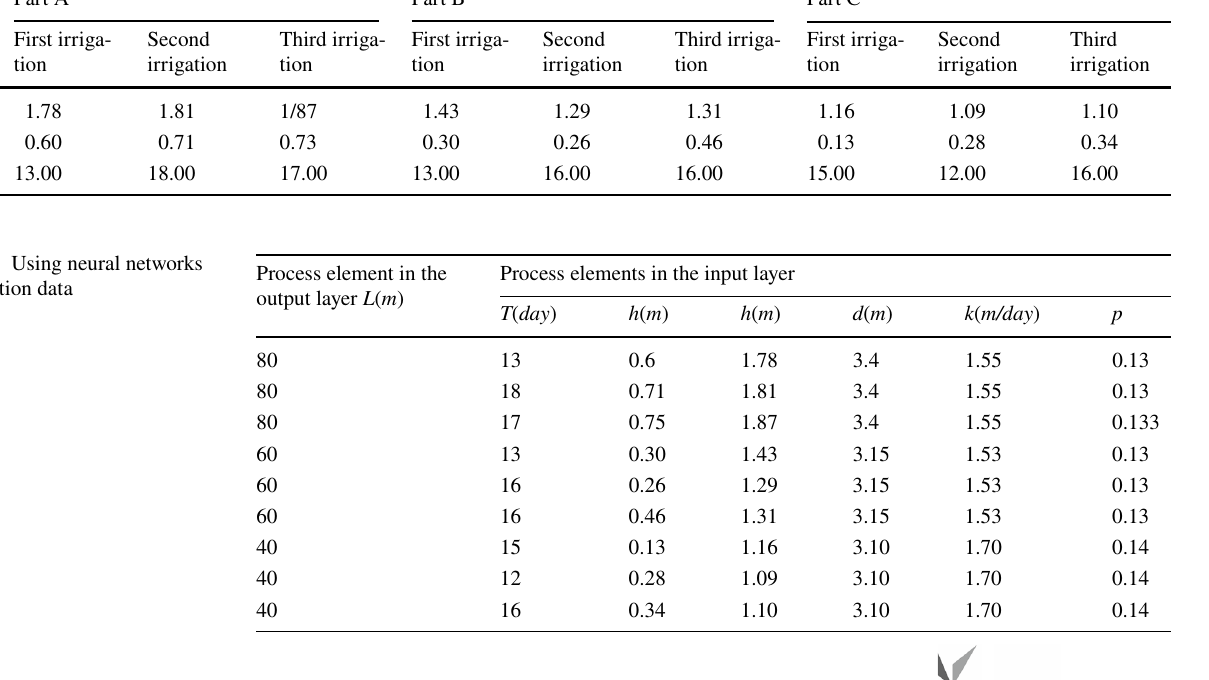
Table 2 The maximum and minimum water levels subside during the three consecutive irrigations in parts A, B, C Part A